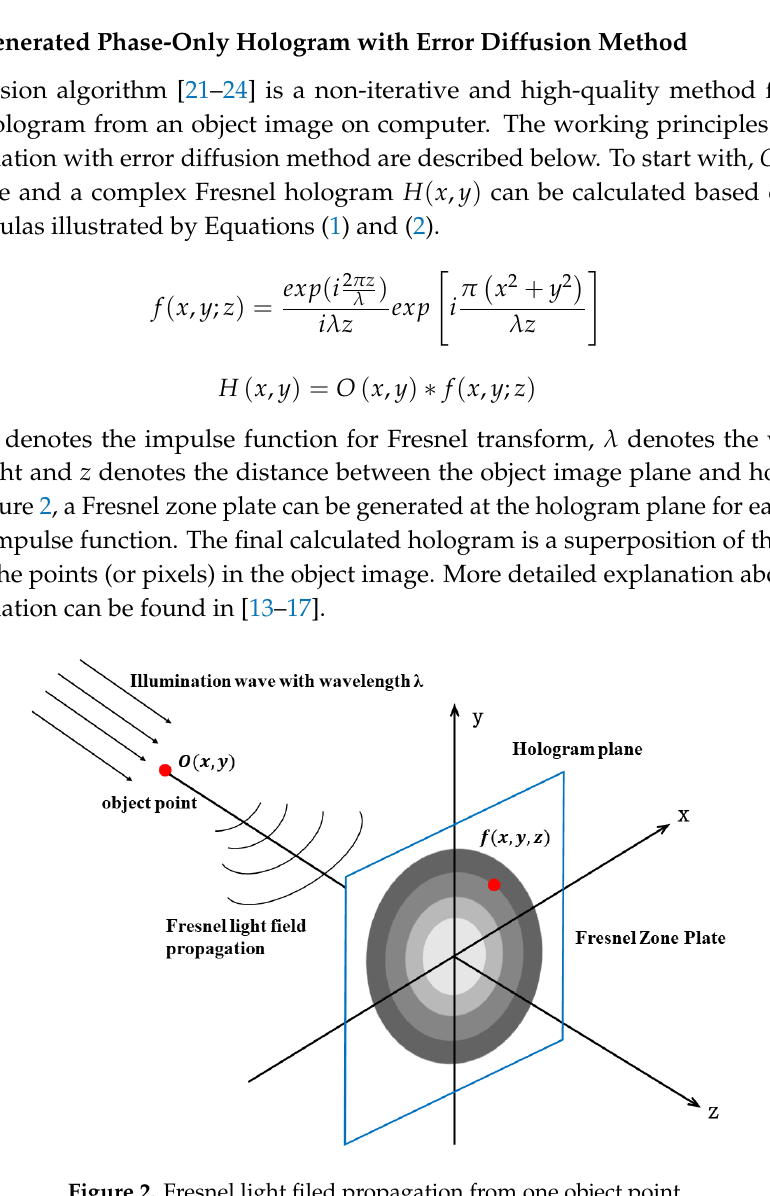
Figure 2. Fresnel light filed propagation from one object